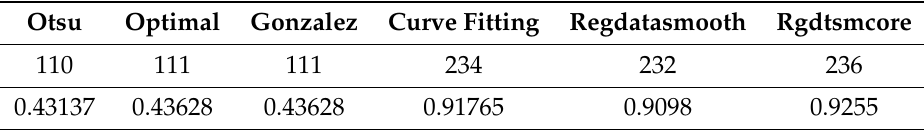
Table 2. Thresholds computed by legacy methods vs. proposed.